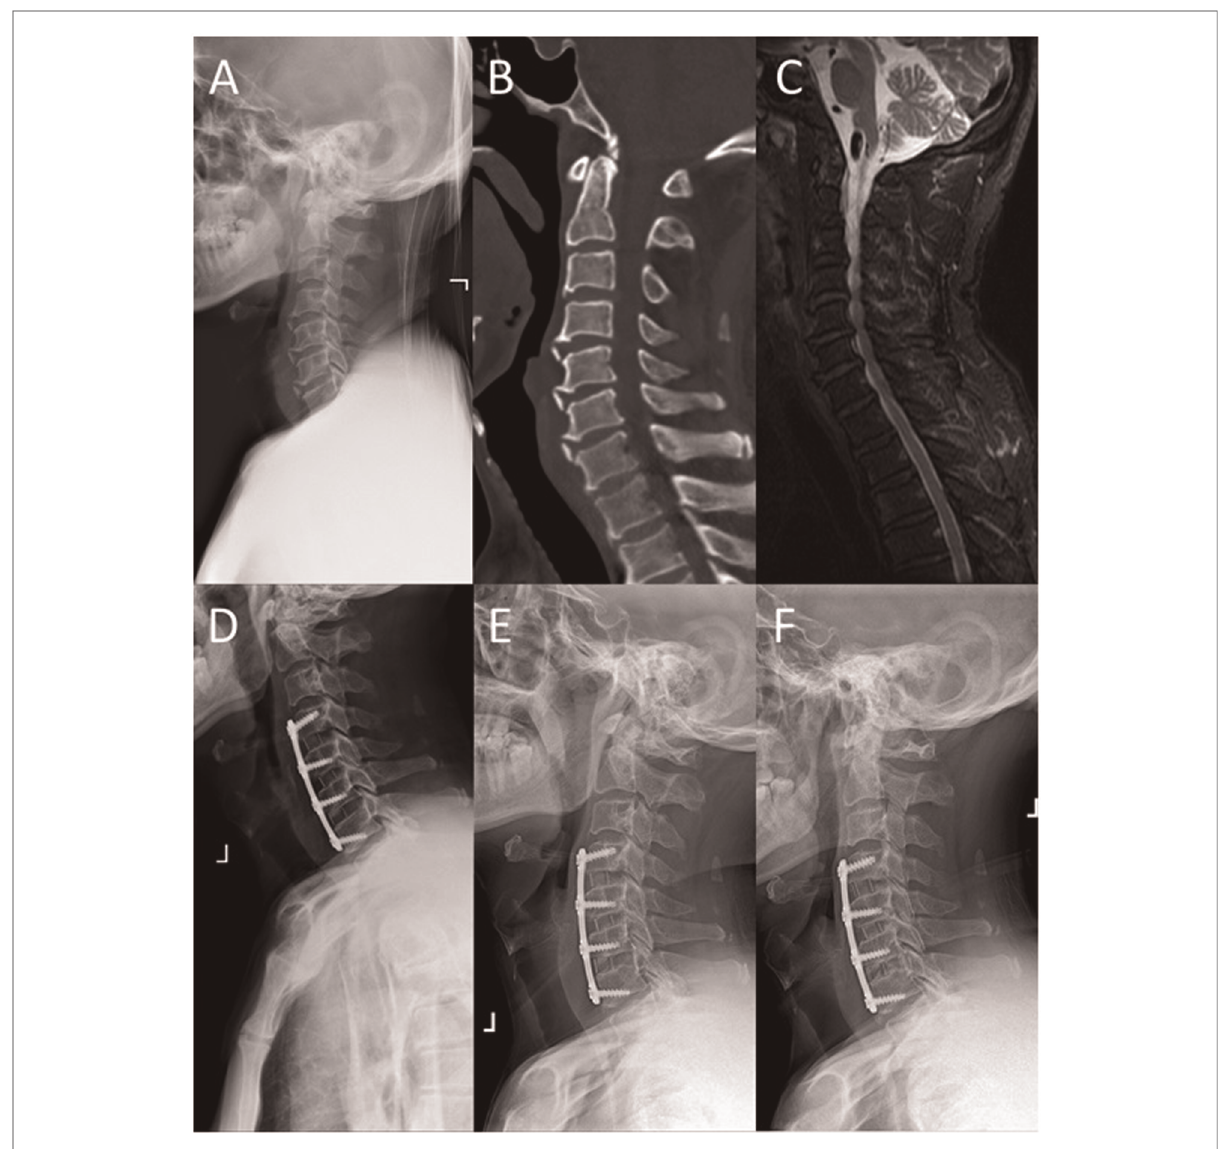
groups postoperatively at 1 month after surgery and